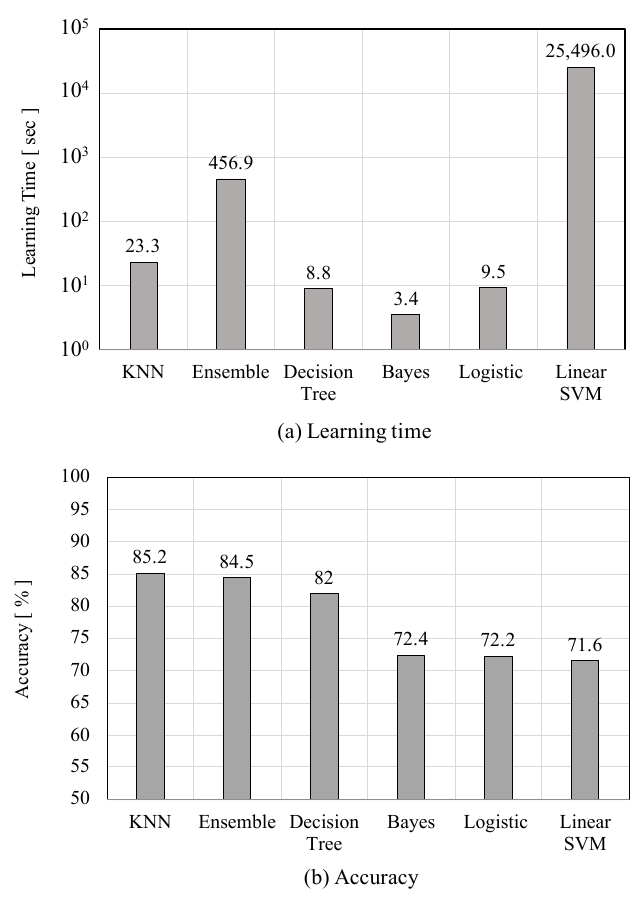
Figure 8. Performance evaluation for different